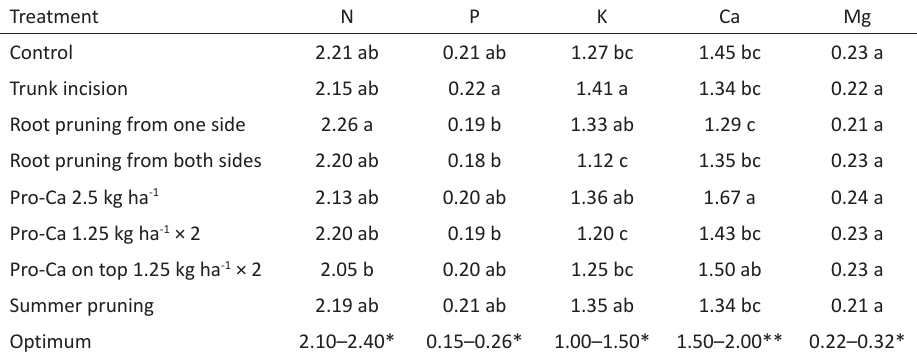
Table 5. Effect of growth control technologies on leaf macronutrient content (%), average of 2017–2018